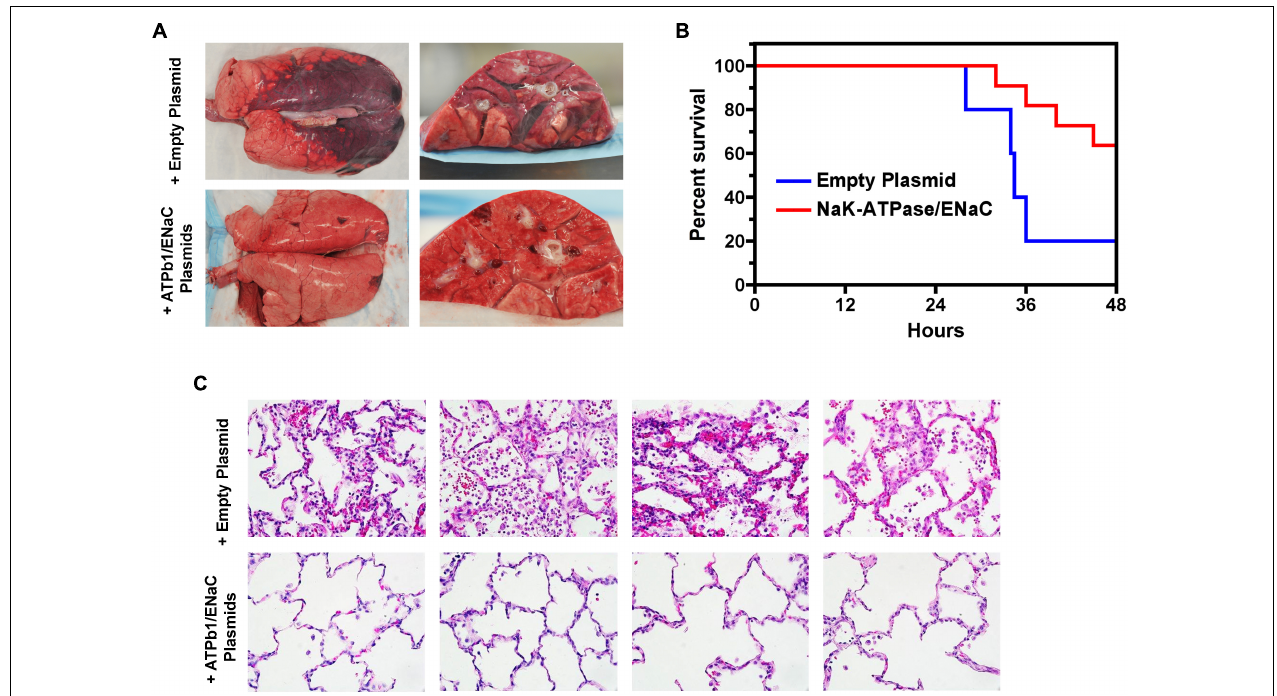
FIGURE 4 | Electroporation-mediated gene transfer of Na + ,K + -ATPase β 1 subunit and α -ENaC plasmids can treat lung injury in a severe septic pig model of ARDS. Lung injury was induced in pigs (40 kg) at t = 0 by inducement of a fecal clot into the abdomen and ischemia-reperfusion injury of the superior mesenteric artery for 30 min and 4 h later, either empty plasmids or plasmids expressing α -ENaC and the Na + , K + -ATPase β 1 subunit (ATP1b1) were delivered to the right and left lower lobes by electroporation. ARDSnet ventilation and vasopressor protocols (Network, 2000) were followed until death or the 48-h pre-set endpoint. (A) Gross histology of lungs from both groups of animals. Note the high degree of atelectasis and glossy presence of excess fluid in lungs from animals receiving empty plasmids. (B) Histology of lungs shows a much lower degree of injury in animals receiving the plasmid treatment. (C) Survival curves show that gene transfer of Na + , K + -ATPase β 1 and α -ENaC plasmids increases survival (Dean,